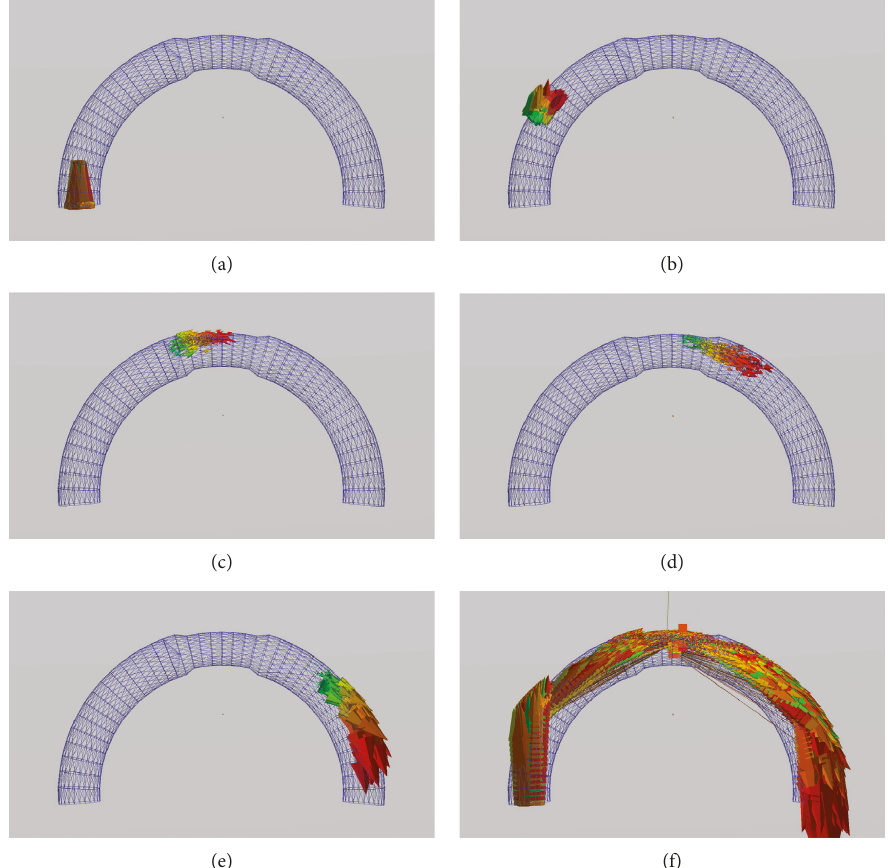
Figure 11: Conceptual example of ray propagation in a virtual half-cone test (ray vector sizes are not to scale). (a) Frame 0. (b) Frame 5k. (c) Frame 10k. (d) Frame 15k. (e) Frame 20k. (f) Accumulated